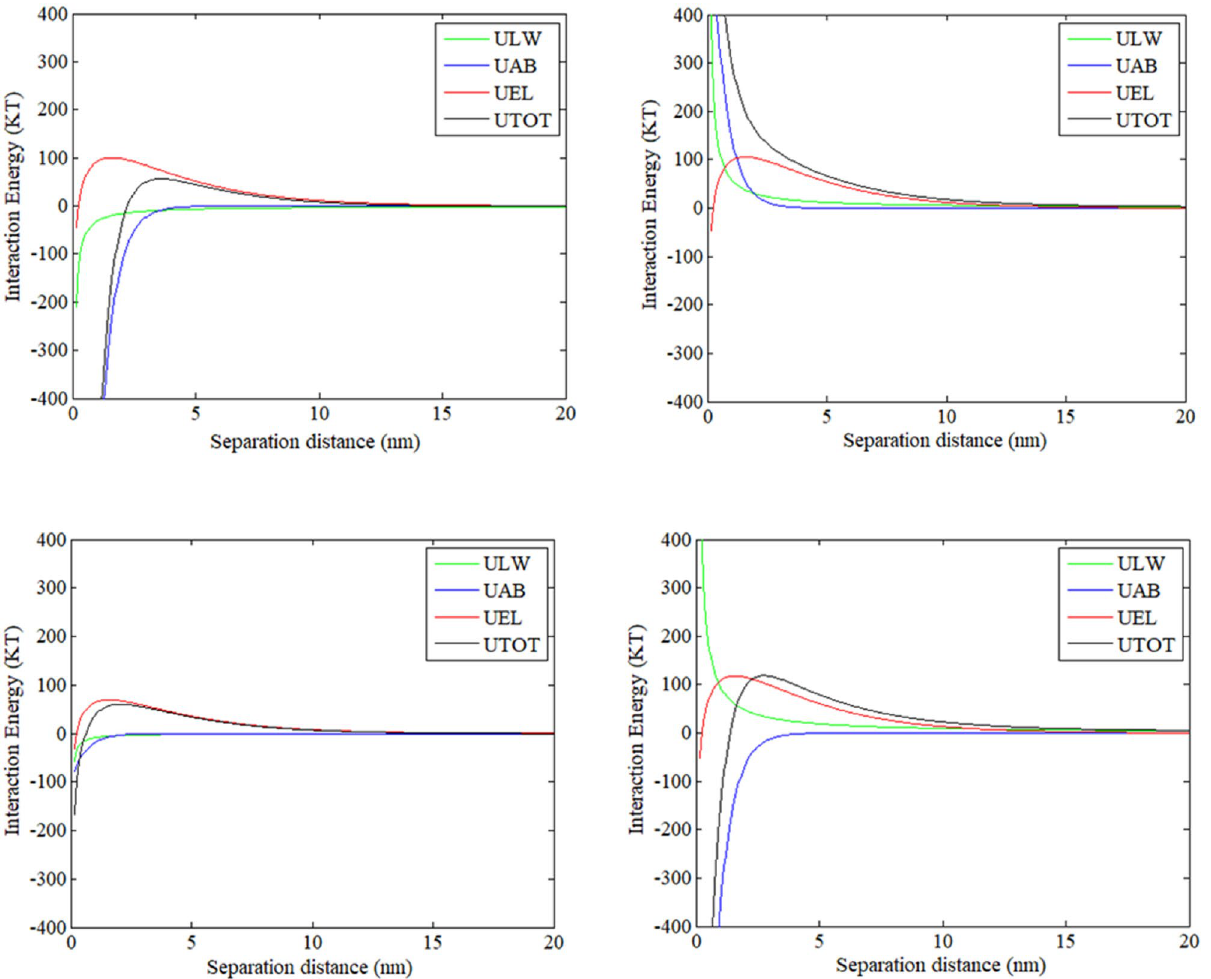
Figure 9. Interaction energy profiles between the clean membrane surface membrane and MA-IOM foulants using the XDLVO theory as a function of separation distance, ( a ) HPO, ( b ) TPI, ( c ) C-HPI, ( d )